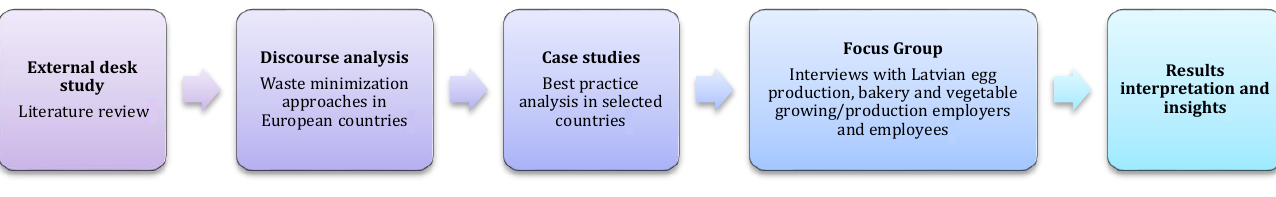
Figure 2. Research methodology